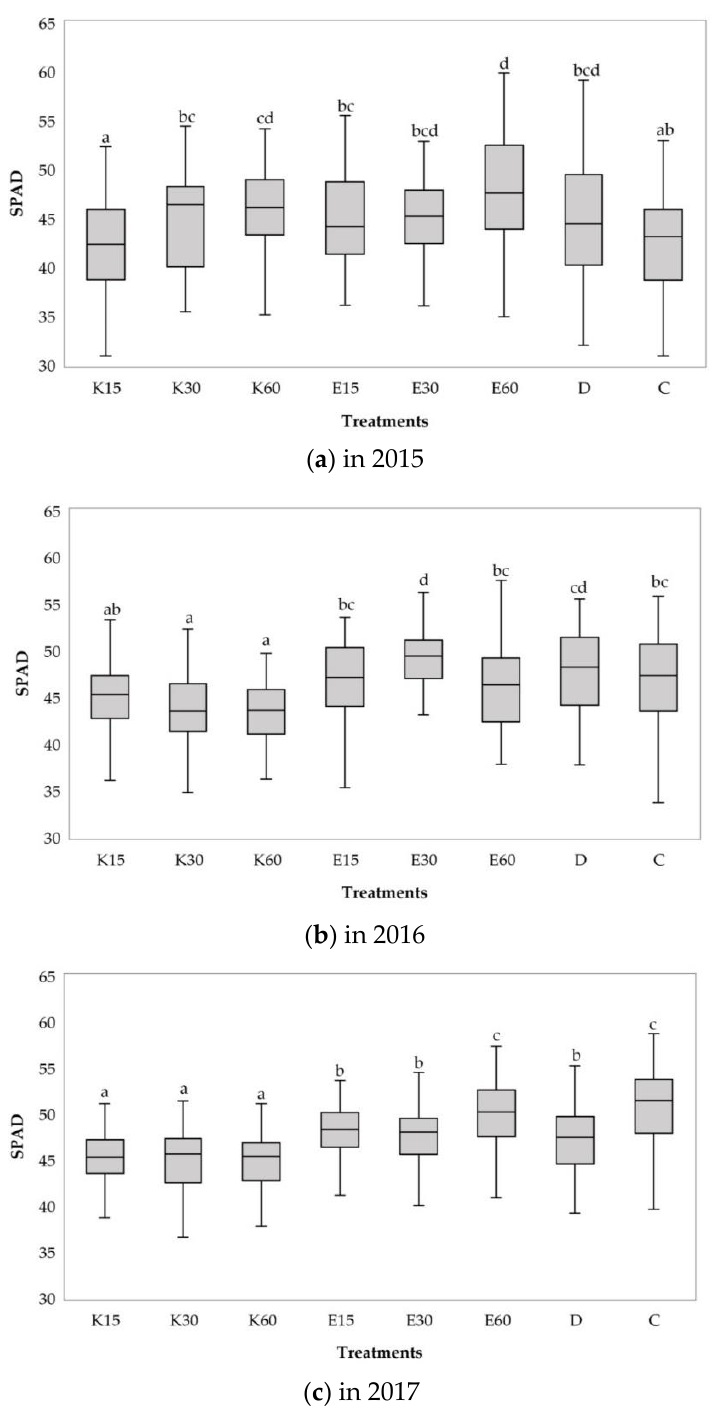
Figure 1. Chlorophyll values from 2015 to 2017 growing years: ( a ) SPAD values of S. alba energy willow coppice in a year of 2015; ( b ) SPAD values of S. alba energy willow coppice in a year of 2016; ( c ) SPAD values of S. alba . energy willow coppice in a year of 2017. Average chlorophyll content data are presented from eight treatments. Results are means ± SD, n = 6. Different letters introduce significant differences among irrigation water qualities for the three vegetation season, in year of 2015 and 2016 confirming to the Tukey’s test at p ≤ 0.05, and in year of 2017 corroborating to the Games-Howell test at p ≤ 0.05.